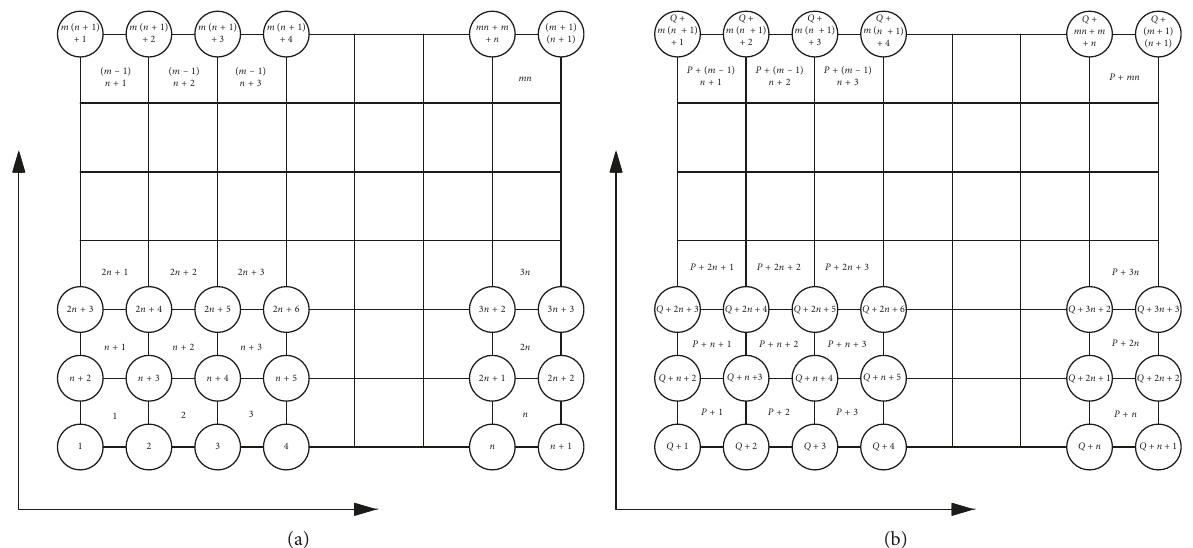
Figure 4: (a) Element and node label for the first CT image pixel matrix; (b) element and node label for no. k CT image pixel